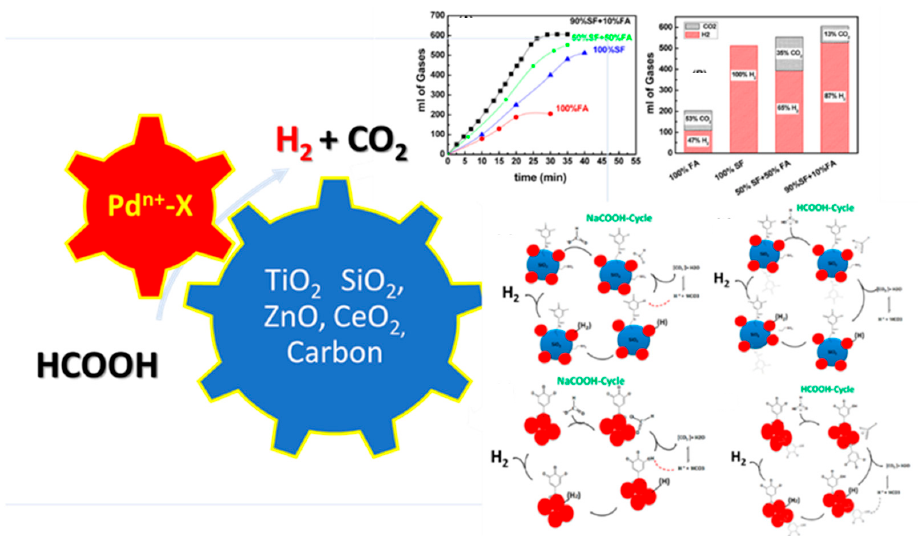
Figure 18. Schematic illustration of FA dehydrogenation reaction. Catalytic results from catalytic dehydrogenation of FA over the Pd@SiO 2 GA material. Adapted from [82] with